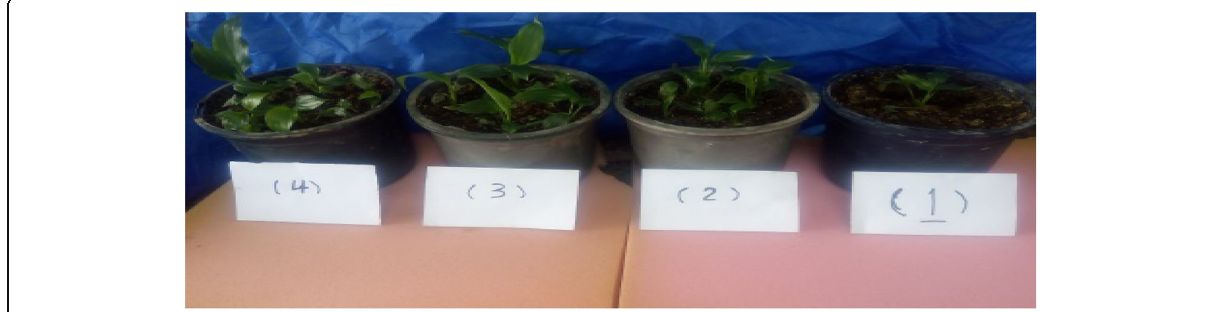
Fig. 2 Spathyiphyllum cannifolium plants during the acclimatization stage. (1) Control, (2) 15 min, (3) 30 min, and (4) 45 min